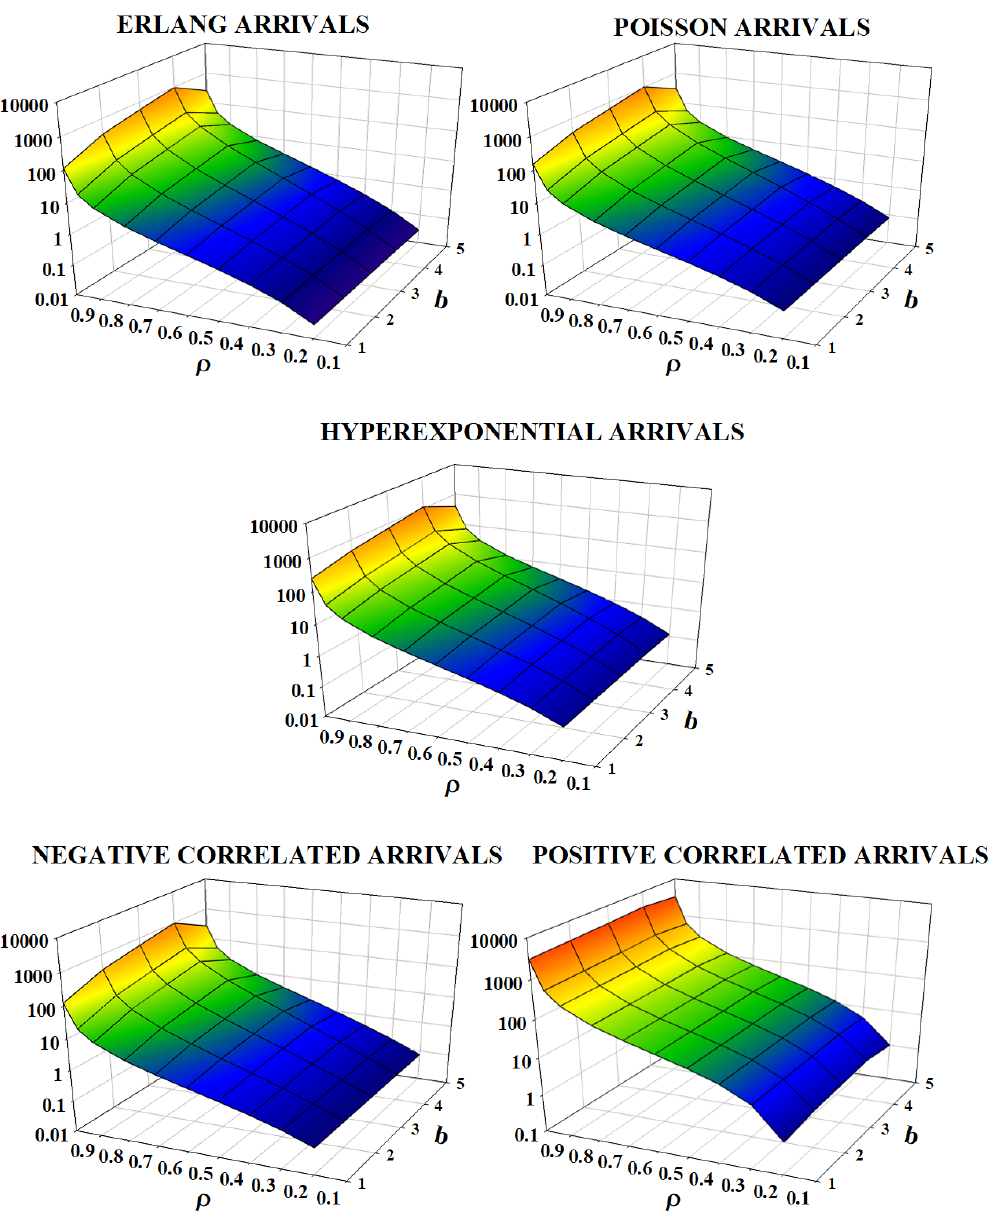
Figure 8. Mean number in queue ( µ N